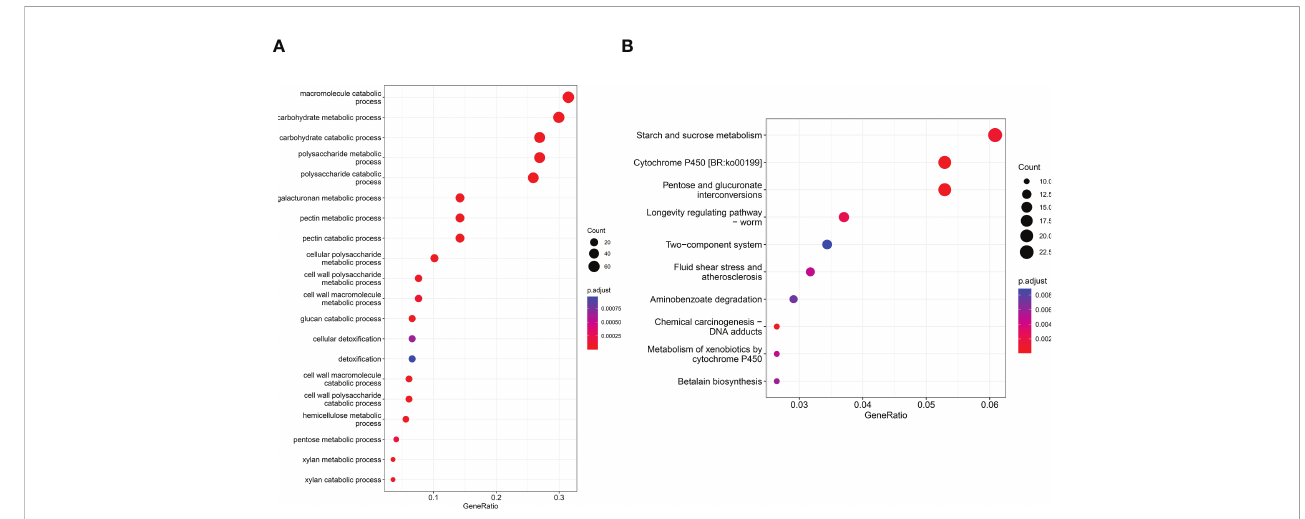
FIGURE 3 GO term distribution (A) and KEGG pathway (B) in relation to R. solani – tobacco